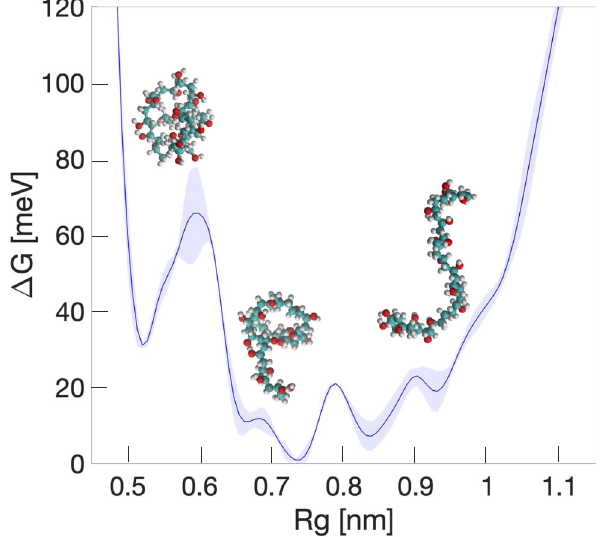
Fig. 2 Conformational landscape of PVA 20 at 300 K. Gibbs free energy ( Δ G ) pro fi le as a function of the radius of gyration R g , obtained by means of metadynamics simulations. PVA 20 is a very fl exible polymer spanning a substantial range of different conformations, all of them separated by energy barriers of the same order of thermal fl uctuations at room temperature ( k B T ~ 25 meV). The shaded region represents the standard error associated with our estimate of Δ G